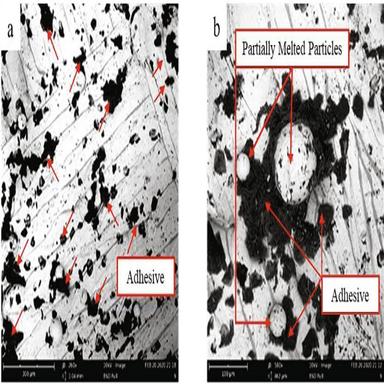
Magnification of fractured areas on the metal side for a) big pyramids, with a magnification of 260×, and b) big pyramids with a magnification of 560×.